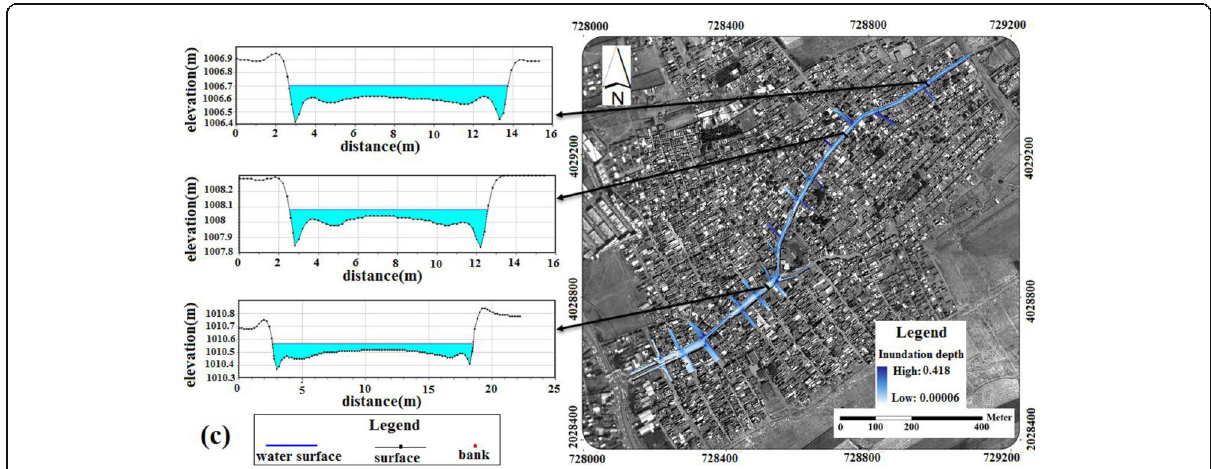
Fig. 10 Inundation zone map and water depth at cross sections profiles in 50 year return period